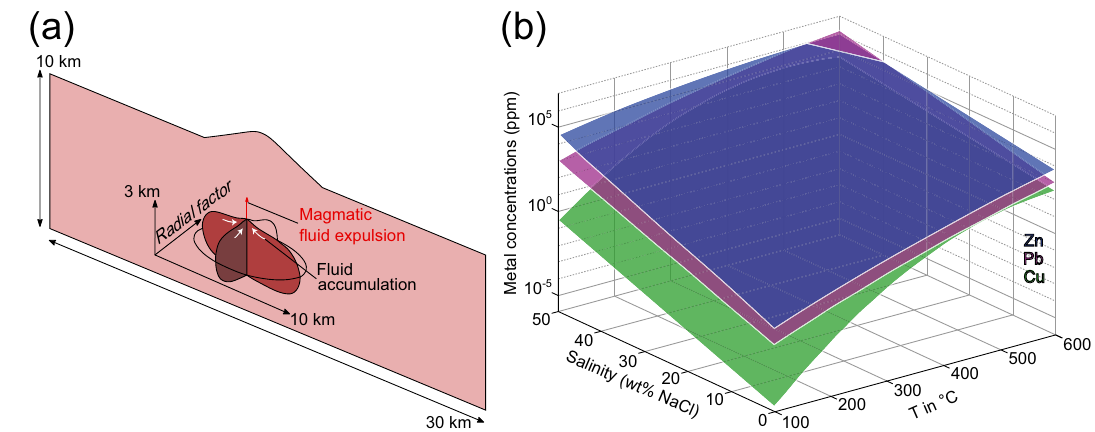
Figure 1. Model configuration and proxies for metal solubilities ( a ) The modeling domain represents a two- dimensional cross-section of the upper crust with dimensions of 10 × 30 km in height and width, including a magma reservoir with an extension of 3 × 10 km. The radial factor describes the extent of the magma chamber in the (unresolved) third dimension relative to the extent in the horizontal direction and thereby controls the total volume of the magma reservoir in three dimensions. Magmatic fluids are assumed to accumulate beneath a cupola region at about 5 km depth before release to the host rock (modified from Weis 26 ). ( b ) Modeled